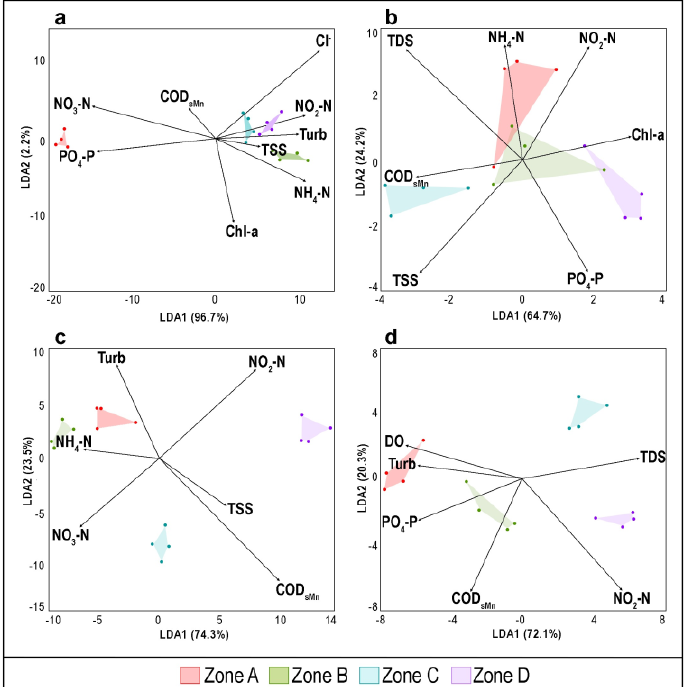
Figure 6. Linear discriminant analysis (LDA) based on the physical-chemical variables during the investigated four seasons. Graph ( a ): April; Graph ( b ): July; Graph ( c ): October; Graph ( d ):